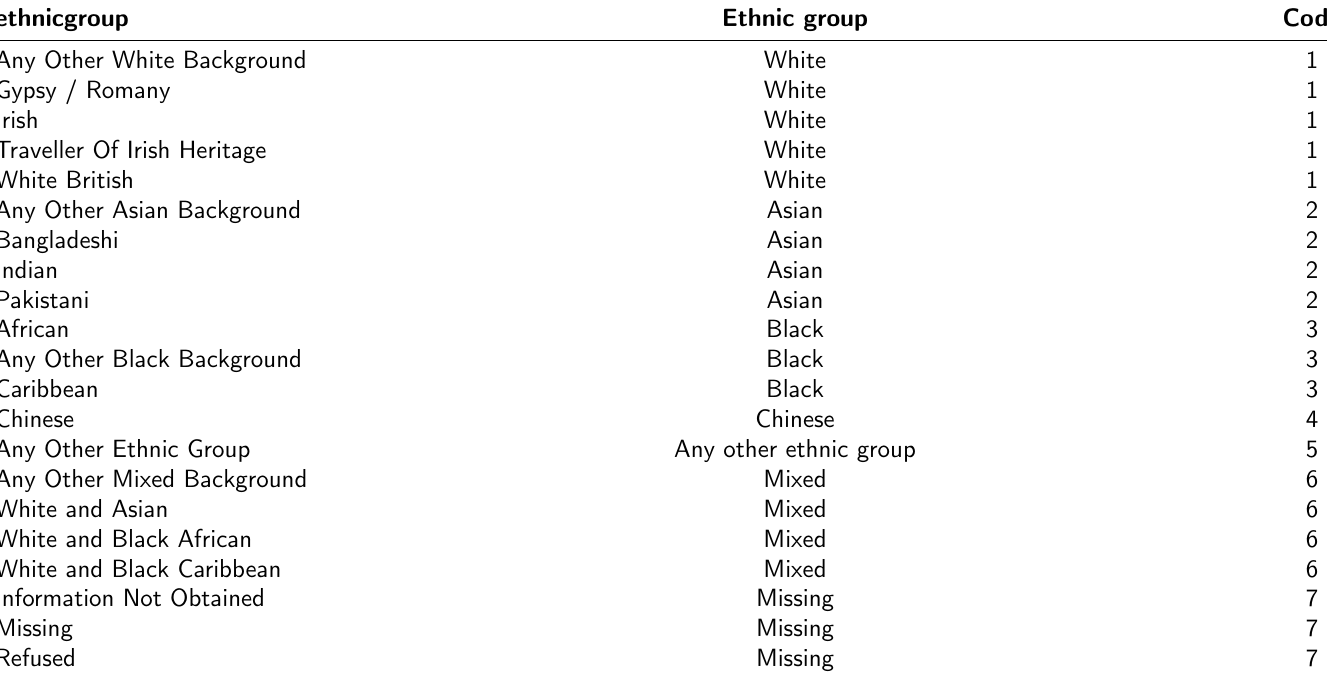
Supplementary Table 4.1: Classification of ethnic group with the ethnicgroup variable